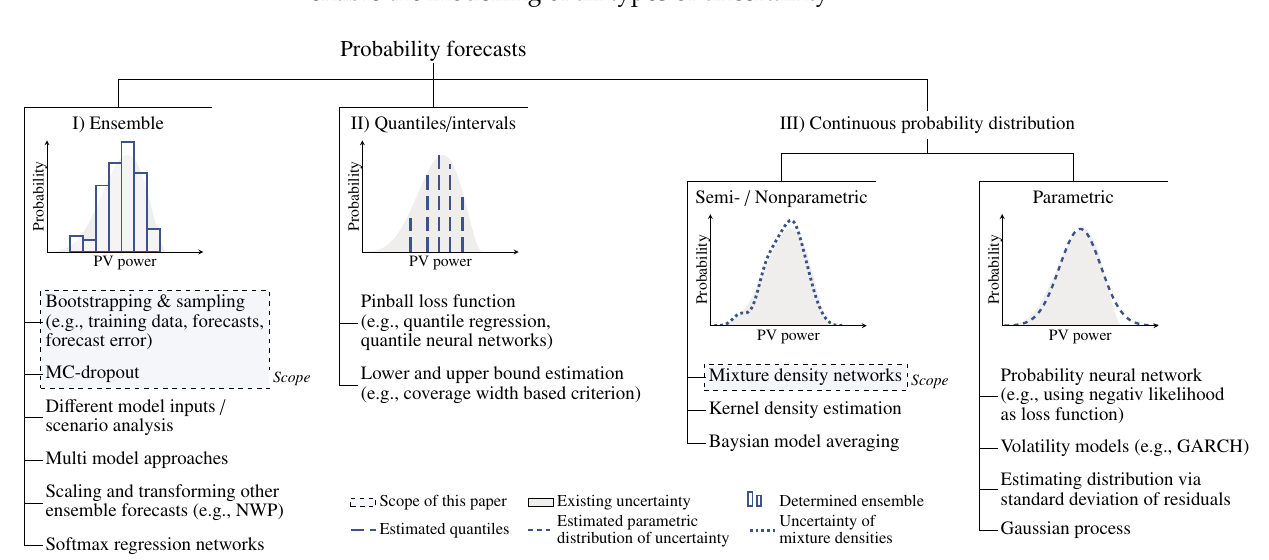
Figure 1. Overview of different representation types for probabilistic forecasts and exemplary methods to generate them. While continuous probability distributions can be both parametric and non-parametric, ensembles and quantile representations never assume a parametric distribution. each other is possible. The approaches explored in this paper are